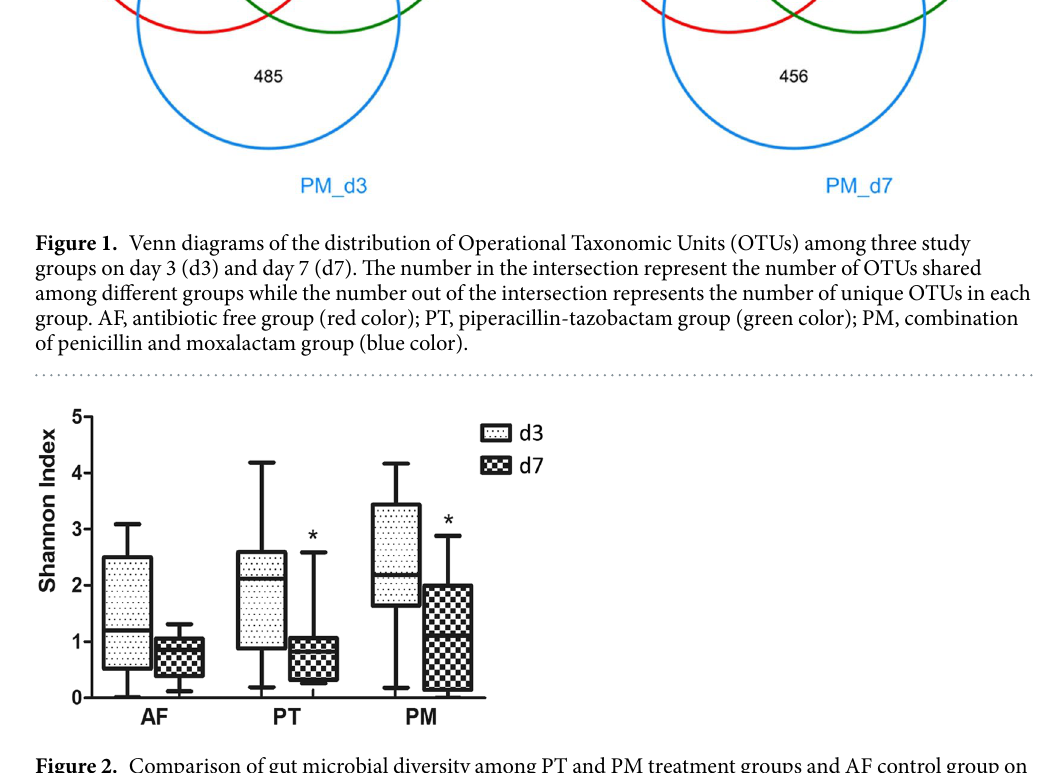
Figure 2. Comparison of gut microbial diversity among PT and PM treatment groups and AF control group on d3 and d7. A bigger Shannon index indicates a higher microbial diversity. The inside bar represents the median, the outer horizontal line of the box represents the 25th and 75th percentiles. Error bars represent the standard error. * Indicates significant differences in the Shannon index between PT and AF groups (P = 0.028) and between PM and AF groups (P = 0.008). For the abbreviation of group names, see Fig. 1